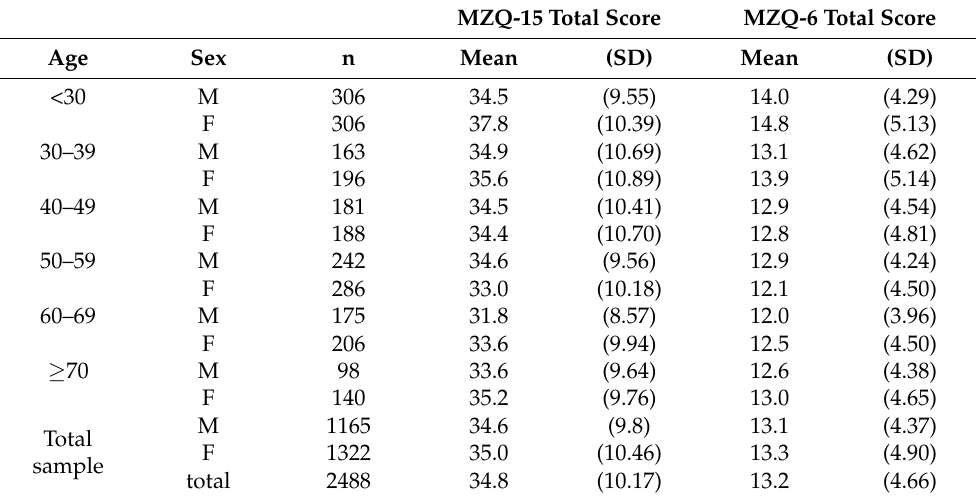
Table 5. Norm values—normed sum scores for the MZQ-15 and MZQ-6 total score for male and female participants across